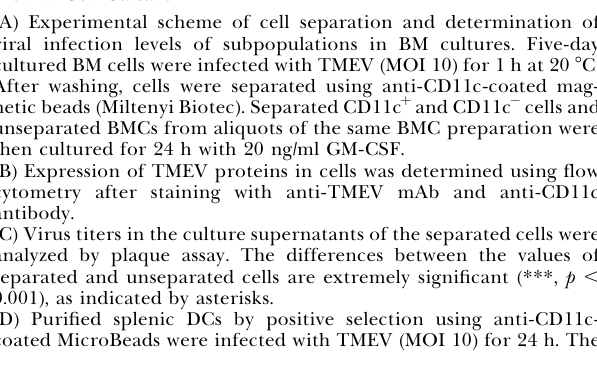
Figure S2. MHC Haplotype H-2 b Is Not Required for DC Resistance to Viral Infection BM DCs from B10.S and their counterpart control mice (B10 and SJL) were infected with TMEV (MOI 10) for 24 h. Expression of TMEV proteins was assessed using anti-TMEV mAb and anti-CD11c anti- body. DCs from B10.S mice exhibiting susceptible H-2 s display resistance to TMEV infection similar to that of B10 mice carrying resistant H-2 b haplotype. Found at doi:10.1371/journal.ppat.0030124.sg002 (10.5 MB PDF). Figure S3. Lower DC Numbers Are Present in Virus-Infected Susceptible SJL Mice (A) The level of CD11c þ cells per femur/tibia or spleen is shown. Each symbol represents the cell frequency or number in each mouse. The average of each group is denoted with horizontal bar. (B) BM cells and splenocytes from mock-infected (filled histogram) or TMEV-infected (open histogram) mice were stained with CD11c, PI, and Annexin V at 2, 4, and 7 dpi. Live DCs (CD11c þ PI (cid:2) cells) were assessed with Annexin V. Relative mean fluorescence intensity of DCs from TMEV-infected mice, differing from the values of DCs from mock-infected mice, is depicted on graphs. Figure S4. DC Subpopulation Distribution Is Different between TMEV-Infected SJL and B6 Mice (A) The expression of CD45, CD11c and CD11b, CD8 a , or CD45RA on CNS-infiltrating cells was assessed at 5 dpi. Data represent the cells gated with CD45 hi cells. The percentage of CD11b-, CD8 a -, or CD45RA-positive cells within the CD45 hi CD11c þ population was shown in the FACS plots. (B) The expression of CD8 a and CD45RA molecules on gated CD11c þ splenocytes was determined at 7 dpi by FACS. Found at doi:10.1371/journal.ppat.0030124.sg004 (3.4 MB